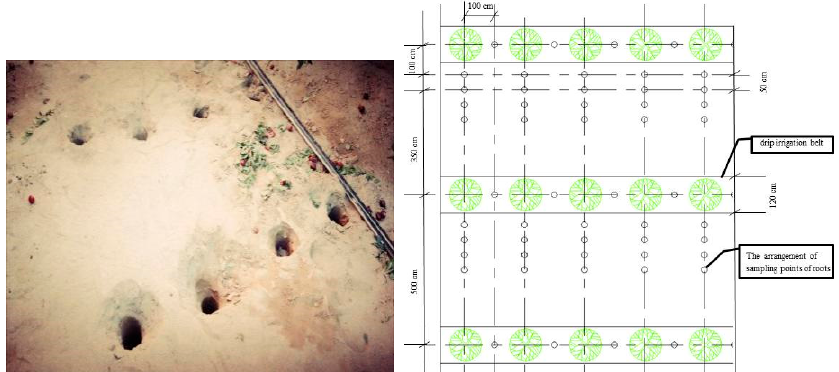
Figure 3. The arrangement of sampling points of roots in Xinjiang.